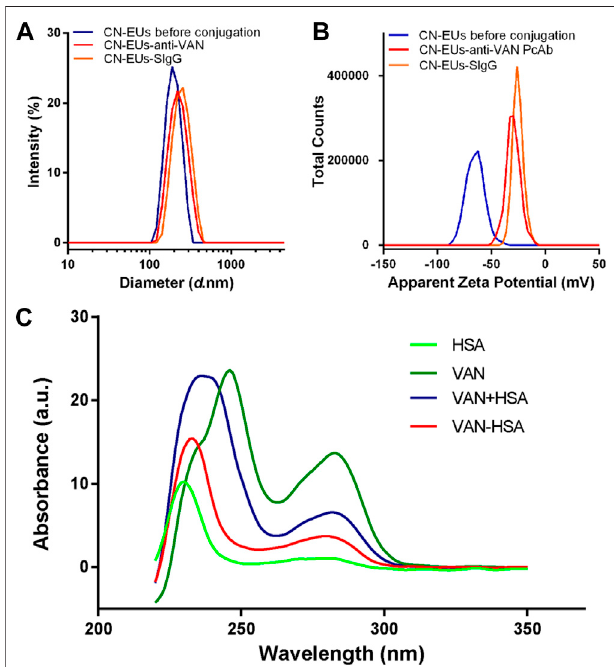
FIGURE 1 | Validation of conjugated nanoparticles and competitive antigen.The (A) particlesizeand (B) ZetapotentialofCN-EUs. (C) TheUV-VIS spectraofVAN-HSA(VANcoupledwithHSA)andVAN+HSA(mixtureofVAN and